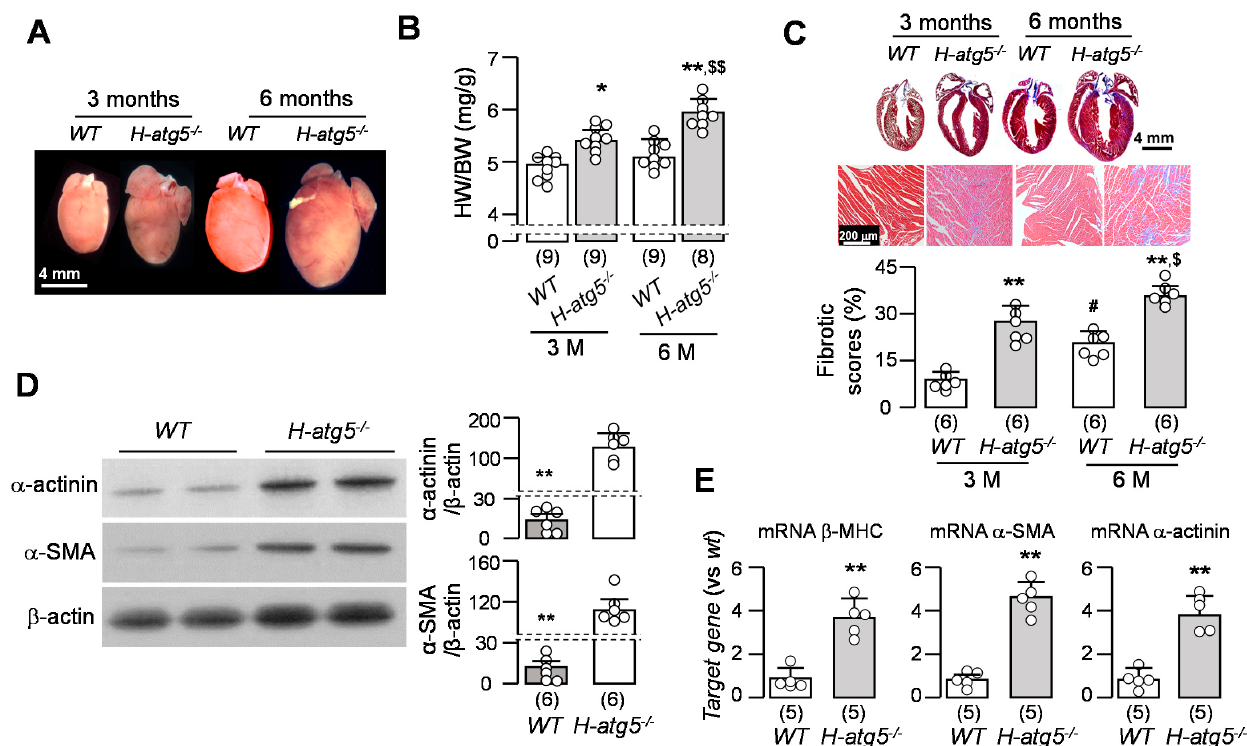
Figure 3. Cardiac hypertrophy and fibrosis in H-atg5 -/- mice. ( A ) Representative images of the hearts of H-atg5 -/- mice and WT mice at 3 and 6 months old. ( B ) Heart weight/body weight in H-atg5 -/- mice and WT mice at 3 and 6 months of age. ( C ) Representative macrographs (upper panel) and micrographs (middle panel) of sagittal TC-stained sections of the hearts of H-atg5 -/- and WT mice at 3 and 6 months of age. Semi-quantification (bottom panel) of the TC-positive area over the whole-heart section with Image J software. ( D ) Changes in hypertrophic and fibrotic markers in the hearts of H-atg5 -/- mice and WT mice at the age of 3 months. Left panel: representative immunoblots for α -actinin and α -SMA in left ventricular lysates. Right panel: a summary of all immunoblot data. ( E ) Quantitative analysis of transcripts of β -MHC, α -SMA, and α -actinin in left ventricular lysates in H-atg5 -/- mice and WT mice at the age of 3 months. Sample number in each group is presented in brackets underneath corresponding bars. Quantitative data are presented as mean ± SD with scatter plots of individual data points. * p < 0.05, ** p < 0.01 vs. WT mice at the same age; # p < 0.05 vs. WT at 3 months old; $ p < 0.05, $$ p < 0.01 vs. H-atg5 -/- mice at 3 months old by two-way ANOVA followed by Student–Newman–Keuls post-hoc test.